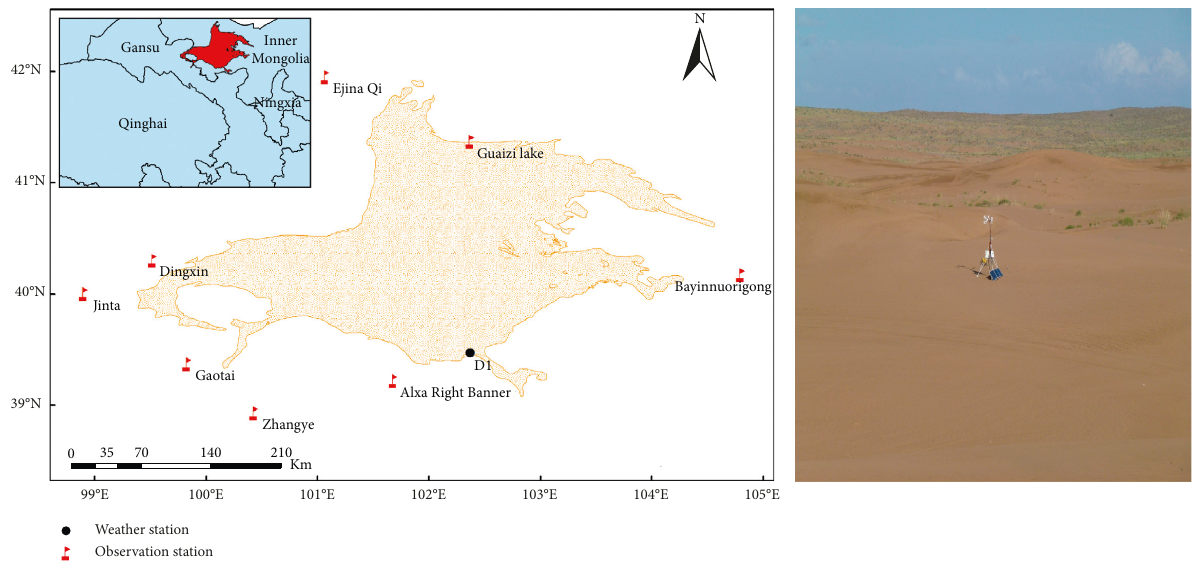
Figure 1: Observation site and surface conditions in the Badain Jaran Desert.